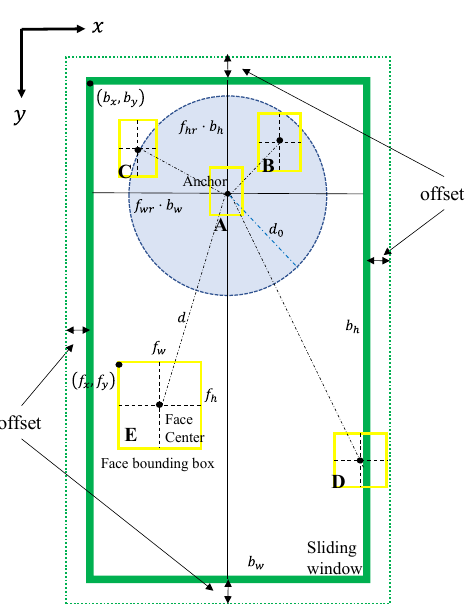
Figure 1. The depiction of the sliding window (green solid box), the face bounding boxes (yellow solid boxes A to E), and the parameters used for the score combination. The edge of the blue-shaded circle marks out the zero-scaled score positions. The scaled scores are positive when face centers are inside this circle and negative when the centers are outside.